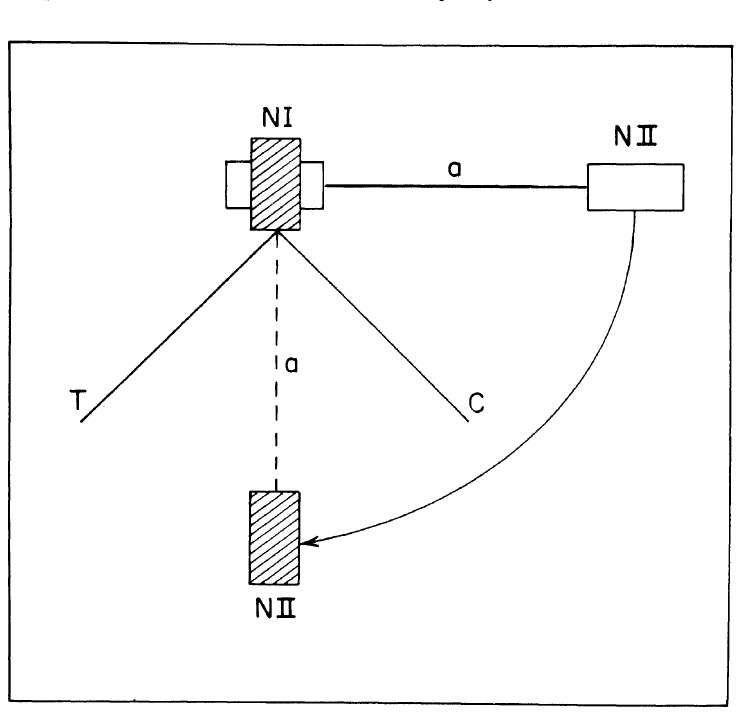
Figure 10. Schematical illustration of the experimental arrangement during trail tests. The colony was emigrating from nest NI to nest NI! along a natural trail a. During the trail tests, the whole arrangement was turned 90 (arrow). The natural trail a was covered by a cardboard, on which the test trail (T) and a control trail (C) were offered, each deviating from a in an angle of 45